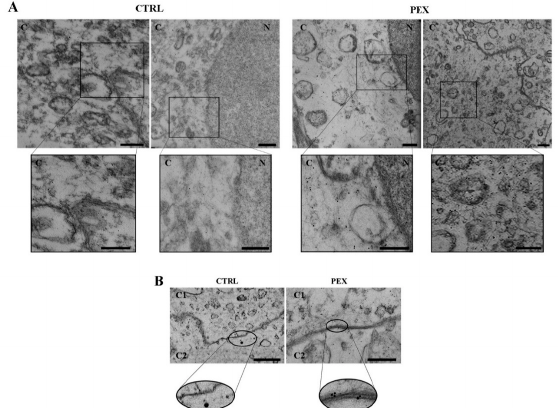
Figure 1. The analysis of the ultrastructural localization of β -catenin in control group vs.pseudoexfoliation syndrome (PEX) group. A single molecule of colloid gold at the cell surface in control group and increased amount of AU in the cytoplasm in the study group. N—nucleus; C—cytoplasm. ( A ). The enhanced accumulation of AU in the area of cell junction in the PEX group in comparison to the control group. C1—cell 1; C2—cell 2. ( B ). Bar—100 nm (inserts—200 nm).